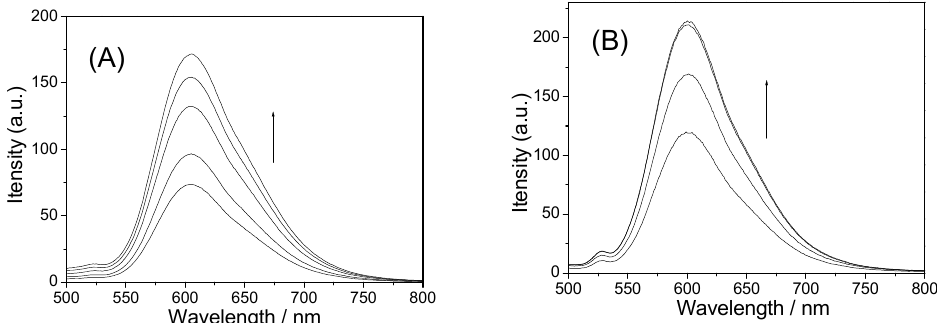
Figure 3. Luminescence spectra of complex 1 ( A ) and 2 ( B ) (5 µ M) with various concentrations of ct-DNA in a tris buffer.